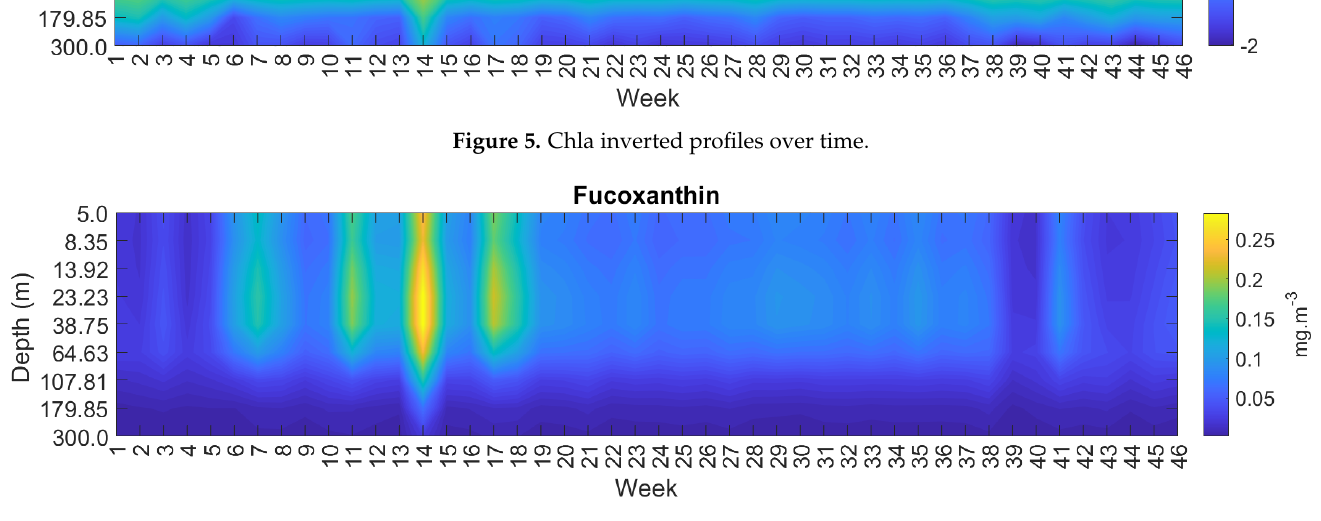
Figure 6. Fucox inverted profiles over